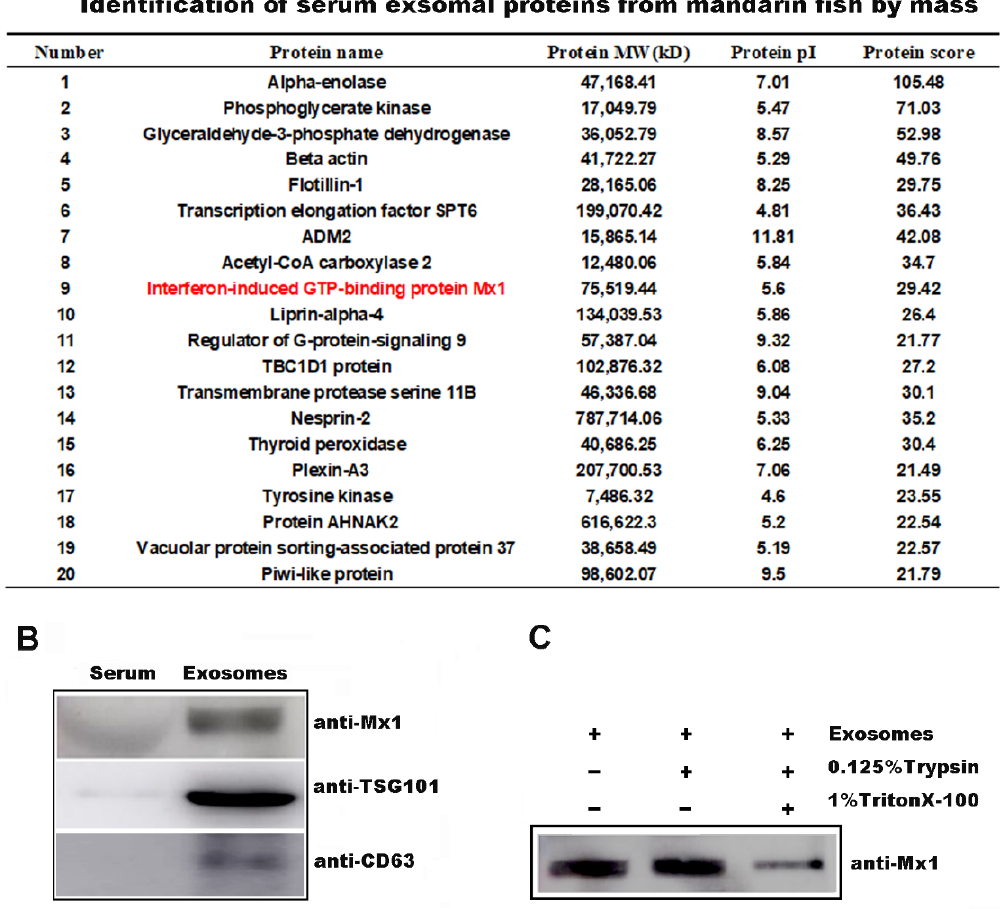
Figure 3. The protein composition of mandarin fish serum-derived exosomes. ( A ) Purified serum-derived exosomes from mandarin fish were analyzed with LC-MS/MS to determine the host proteins. ( B ) Mx1 proteins presented in serum-derived exosomes were confirmed by Western blots with antibody directed against Mx1. Left: untreated mandarin fish serum. Right: purified serum-derived exosomes. ( C ) The assay of exosome resistance to trypsin digestion. The same amounts of exosomes were used for each condition (10 µ g); line 1 is control, mock treated (exo); line 2 is incubated with trypsin (0.125% Trypsin) for 30 min at room temperature; line 3 is treated with 1% Triton X-100 for 5 min before incubation with trypsin (0.125% trypsin). Western blot analysis with antibody directed against Mx1.